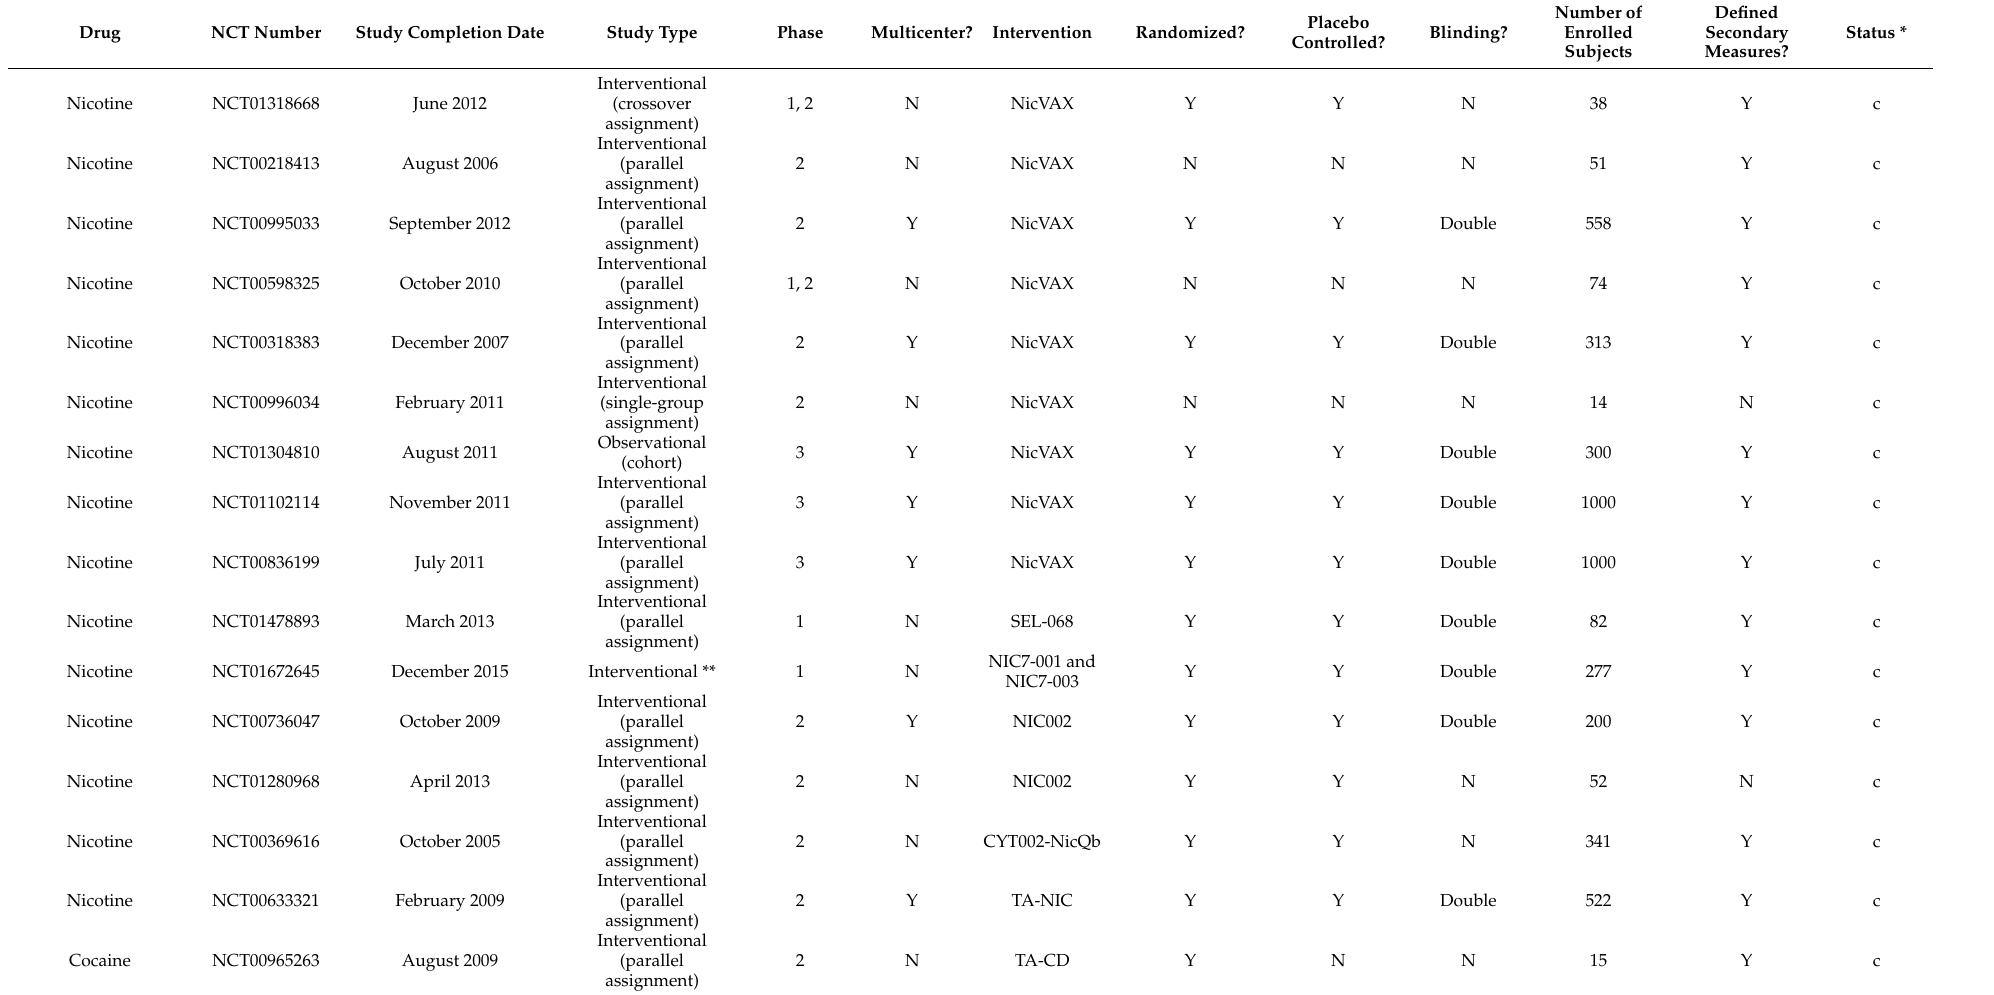
Table 1. Summary of the details of clinical trials for treatments against nicotine, cocaine, methamphetamine, and opioid abuse